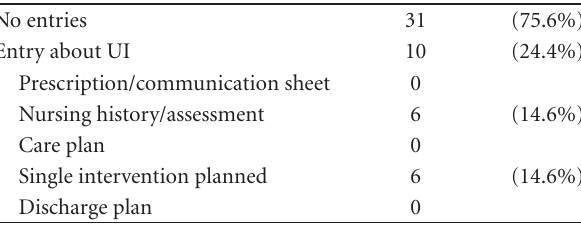
Table 2: Signs of identification of UI in the nursing records of incontinent patients ( n = 41).